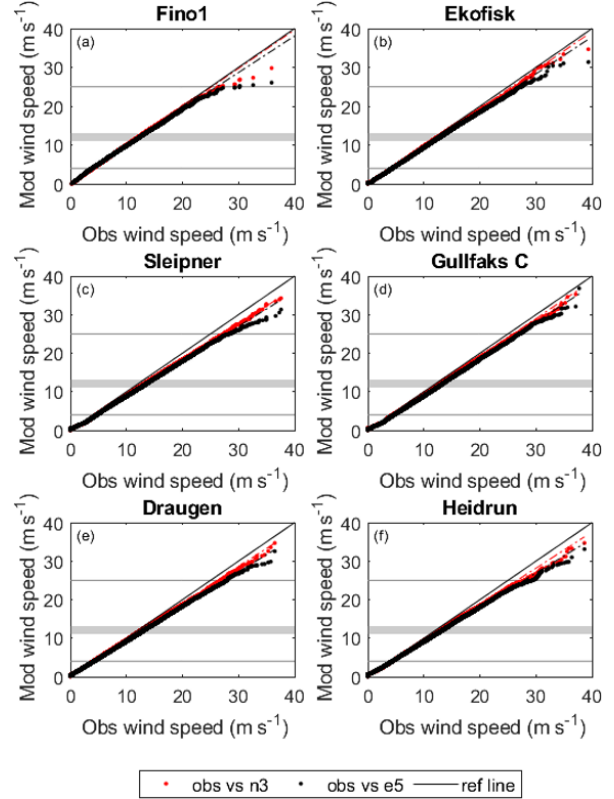
Figure 2. Quantile–quantile plot between the observed wind speed (obs) and the modeled (mod) wind speed, with NORA3 shown in red and ERA5 shown in black, for all the six offshore sites.